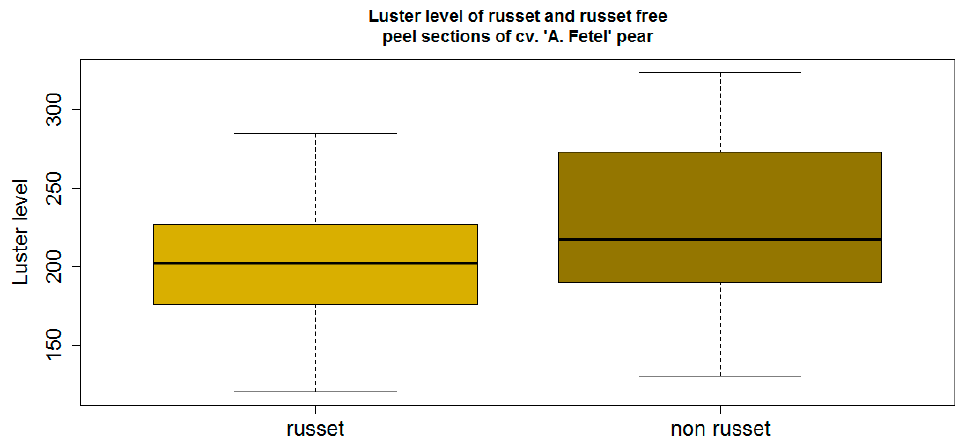
Figure 5. Luster values of russet and russet-devoid brown peel sections of cv. “Abate Fetel” pears (statistics: p = 0.09 >> α = 0.05; n =18).